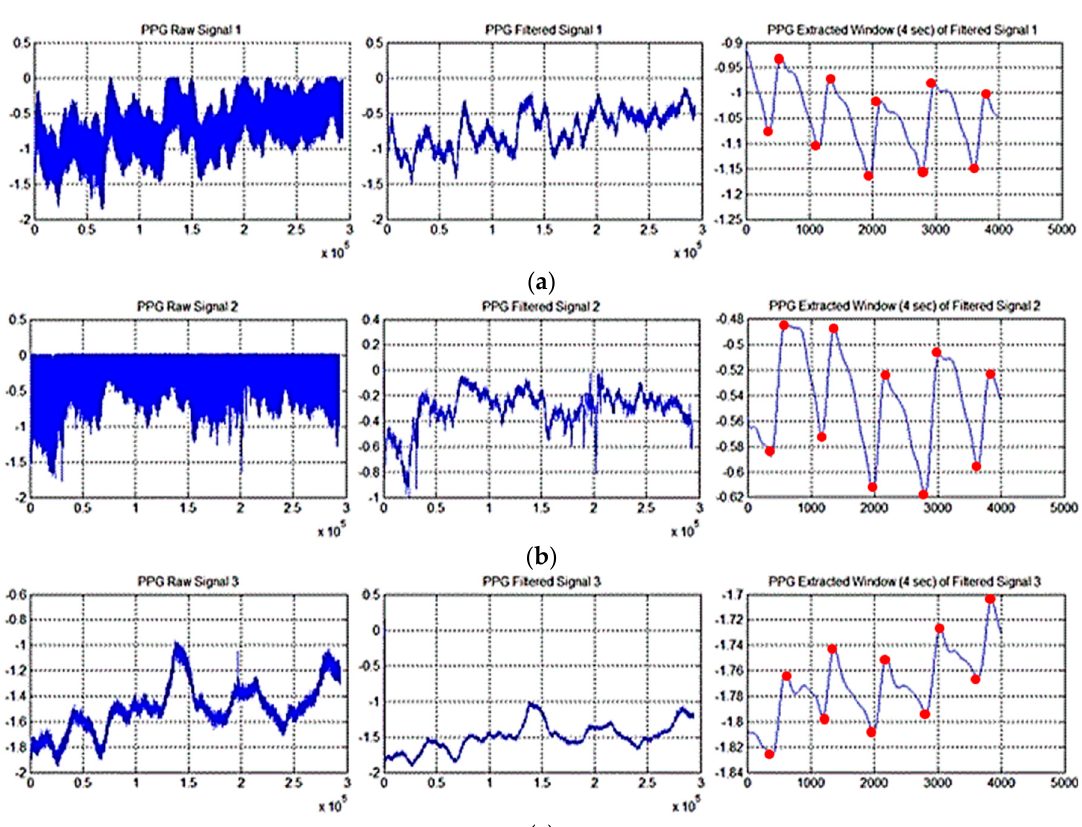
Figure 6. ( a ) The plot in the first column reports the PPG Raw Signal 1 (left wrist). The second window reports same PPG raw signal filtered as per FIR filters previously described. Latest column shows an enlarged window of the filtered PPG signals; ( b ) The plot in the first column reports the PPG Raw Signal 2 (right wrist). The second window reports same PPG raw signal filtered as per FIR filters previously described. Latest column shows an enlarged window of the filtered PPG signals; ( c ) The plot in the first column reports the PPG Raw Signal 3 (ankle). The second window reports same PPG raw signal filtered as per FIR filters previously described. Latest column shows an enlarged window of the filtered PPG signals.